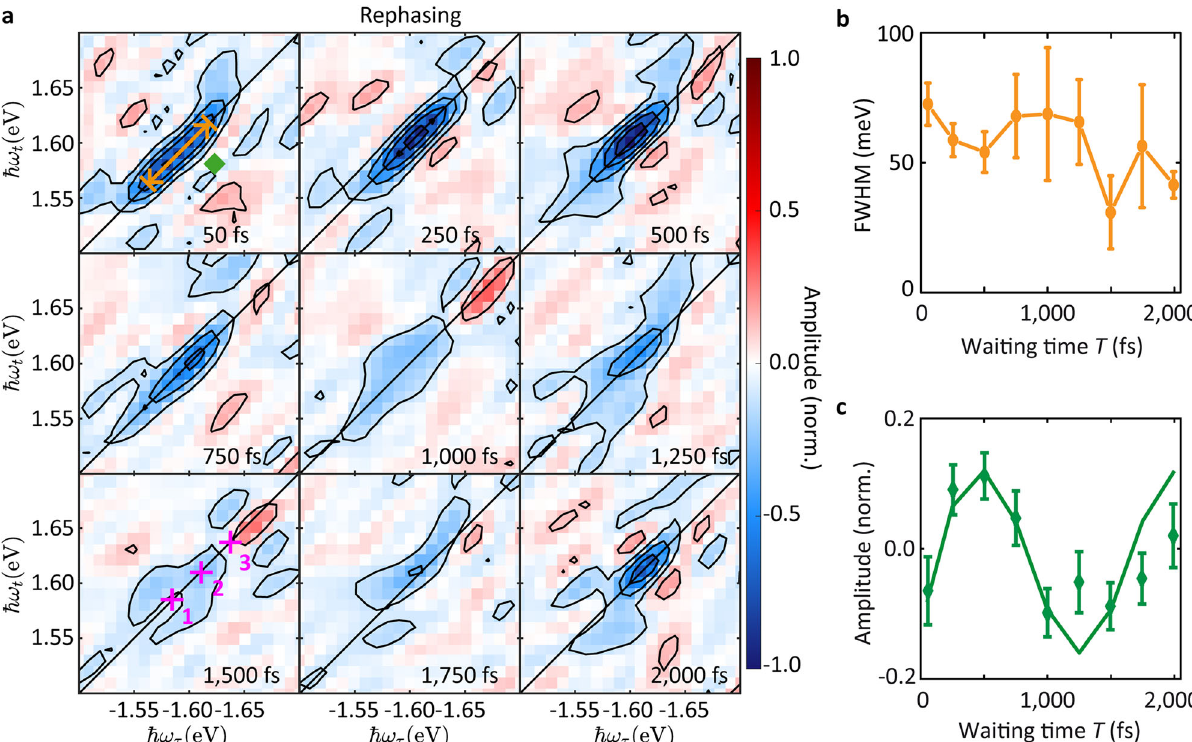
Fig. 2 Beating signal in the rephasing 2d maps. a Rephasing 2d maps at different T , normalized to the maximum absolute value of the real part of the map at T = 500 fs. b Diagonal linewidth (FWHM, indicated by the orange double arrow at T = 50 fs in panel a ) versus T . The error bars depict 95% con fi dence bounds from fi tting the diagonal slices by a Gaussian function. c Amplitude evolution (green diamonds) of one pixel (marked by the green diamond at T = 50 fs in panel a ) and fi t (solid green curve). The error bars are evaluated by calculating the fl uctuations within a region containing background noise (see Supplementary Note